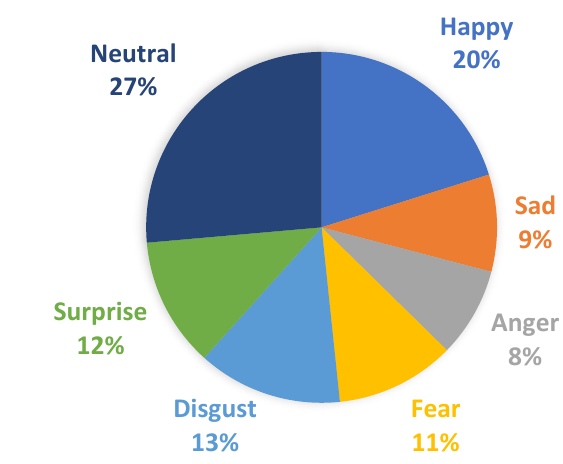
Figure 6. Data distribution of the emotion labels.